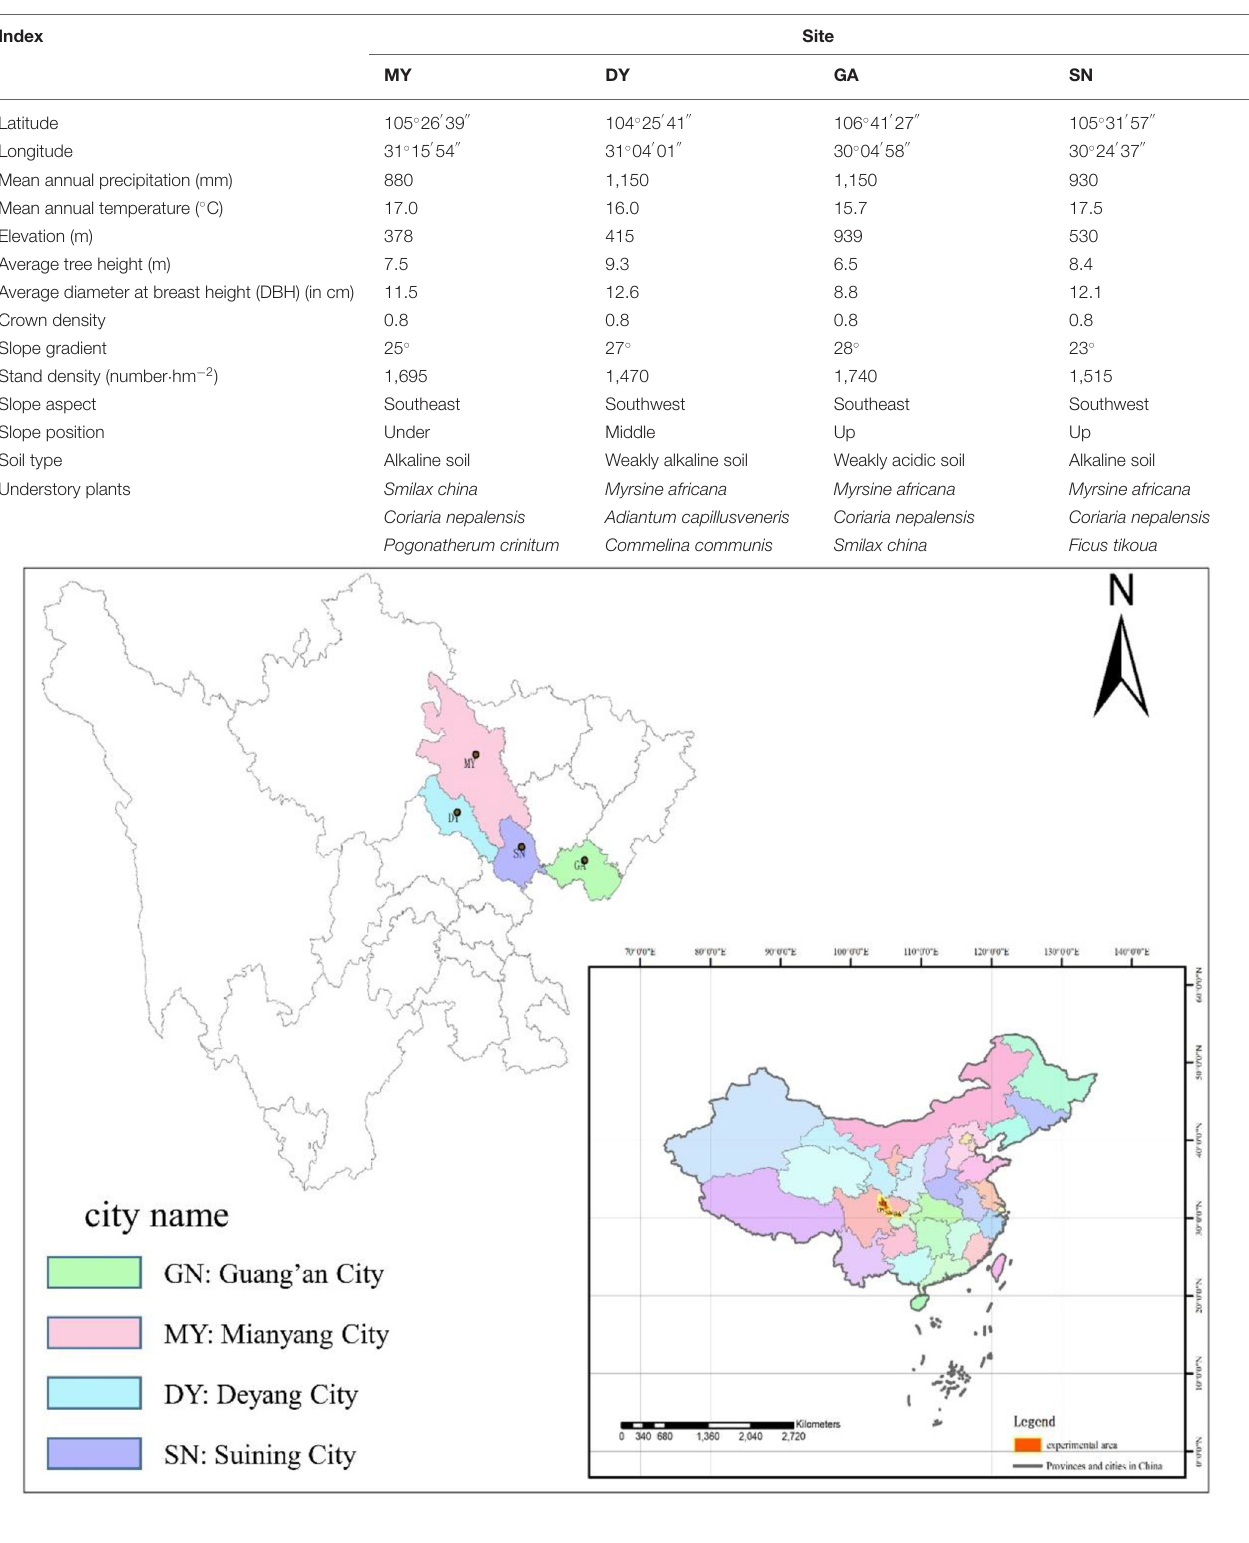
TABLE 1 | General information of the four test sites used in the